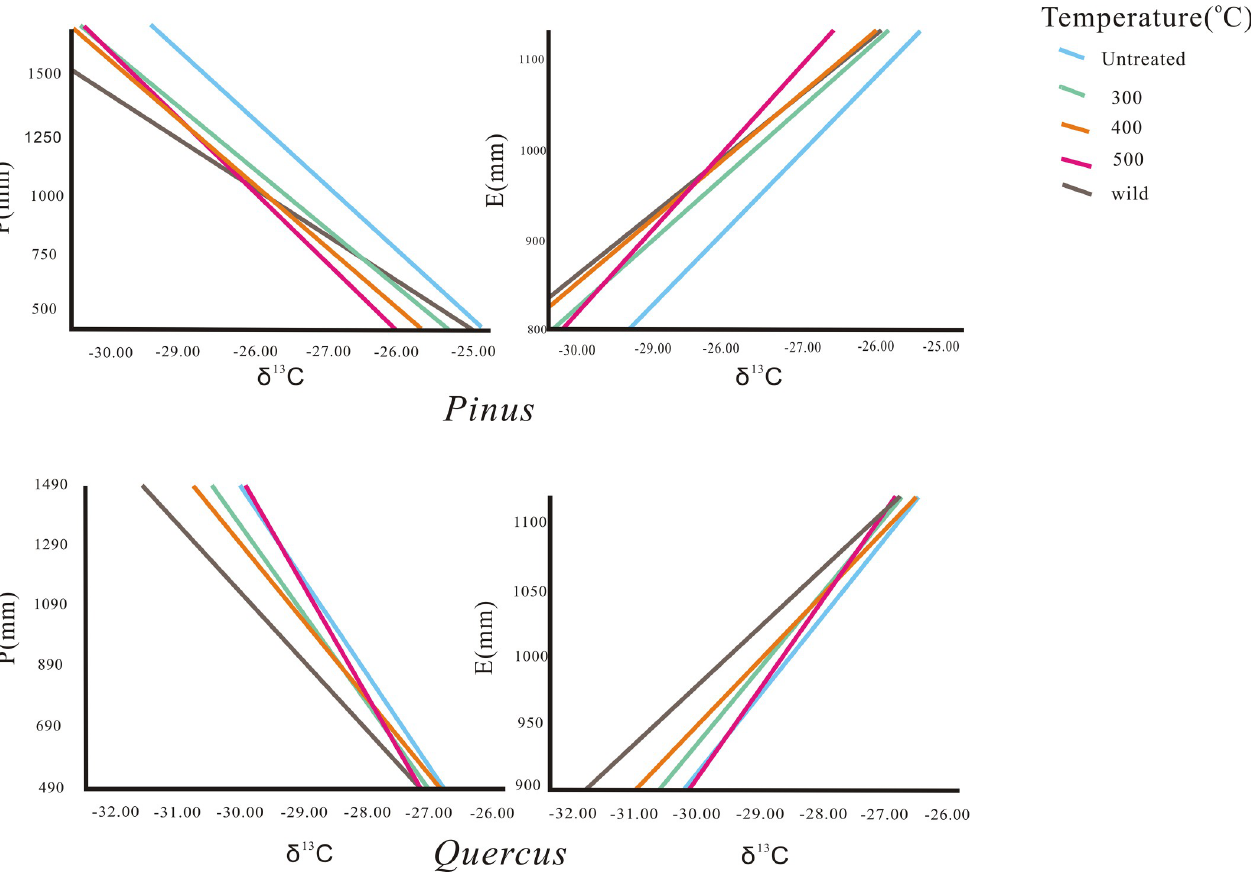
Fig 6. Relationship between the δ 13 C (‰ VPDB) value and climate